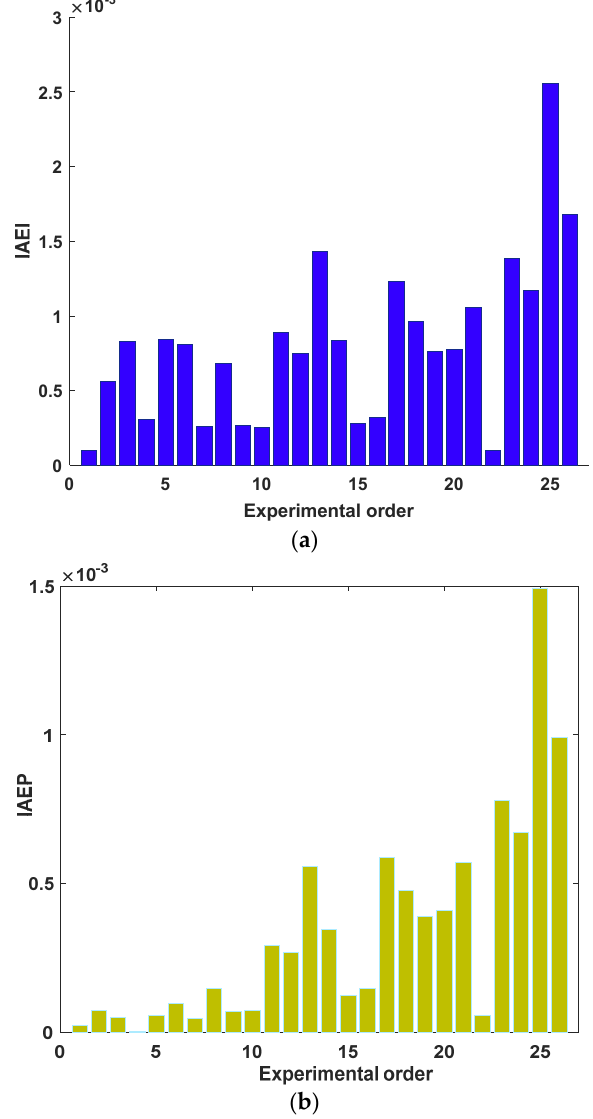
Figure 18. Individual absolute errors for current and power by the MECPO for TDM. ( a ) Individual absolute errors for current. ( b ) Individual absolute errors for power.